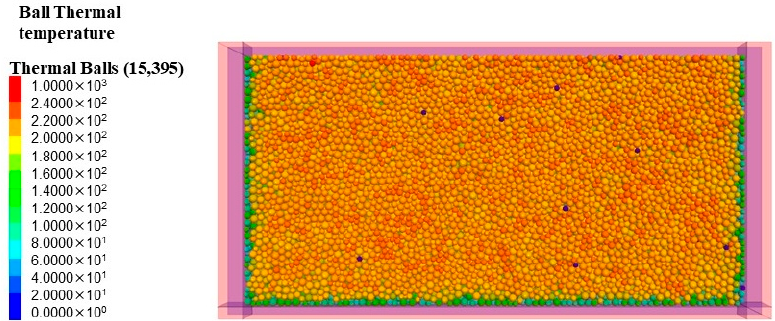
Figure 11. Numerical simulation of fire resistance test.